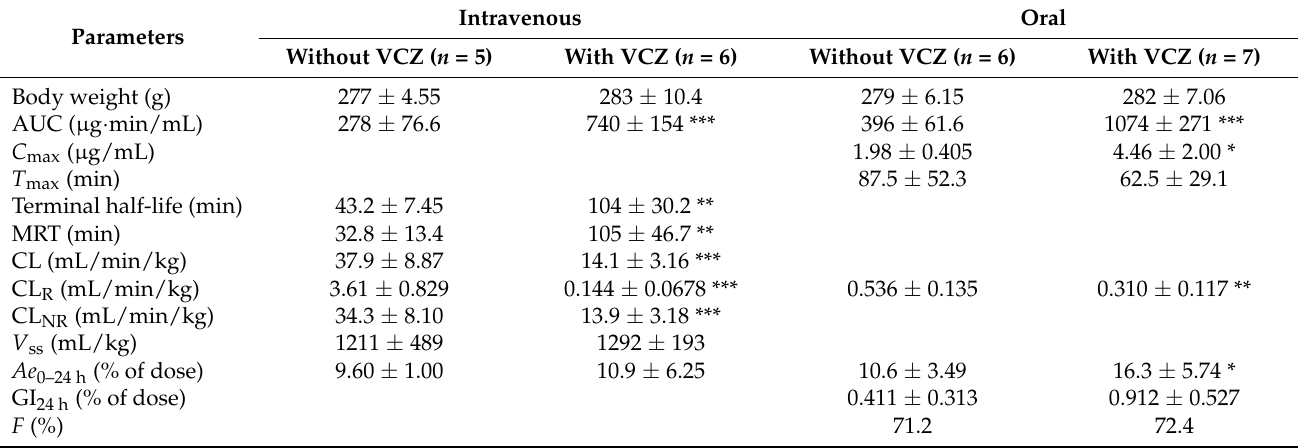
Table 1. Pharmacokinetic parameters of tofacitinib after intravenous (10 mg/kg) and oral (20 mg/kg) administration of tofacitinib without and with voriconazole (VCZ, 10 and 20 mg/kg for intravenous and oral administration, respectively) to Sprague–Dawley rats. Values are means ± standard deviation (SD).